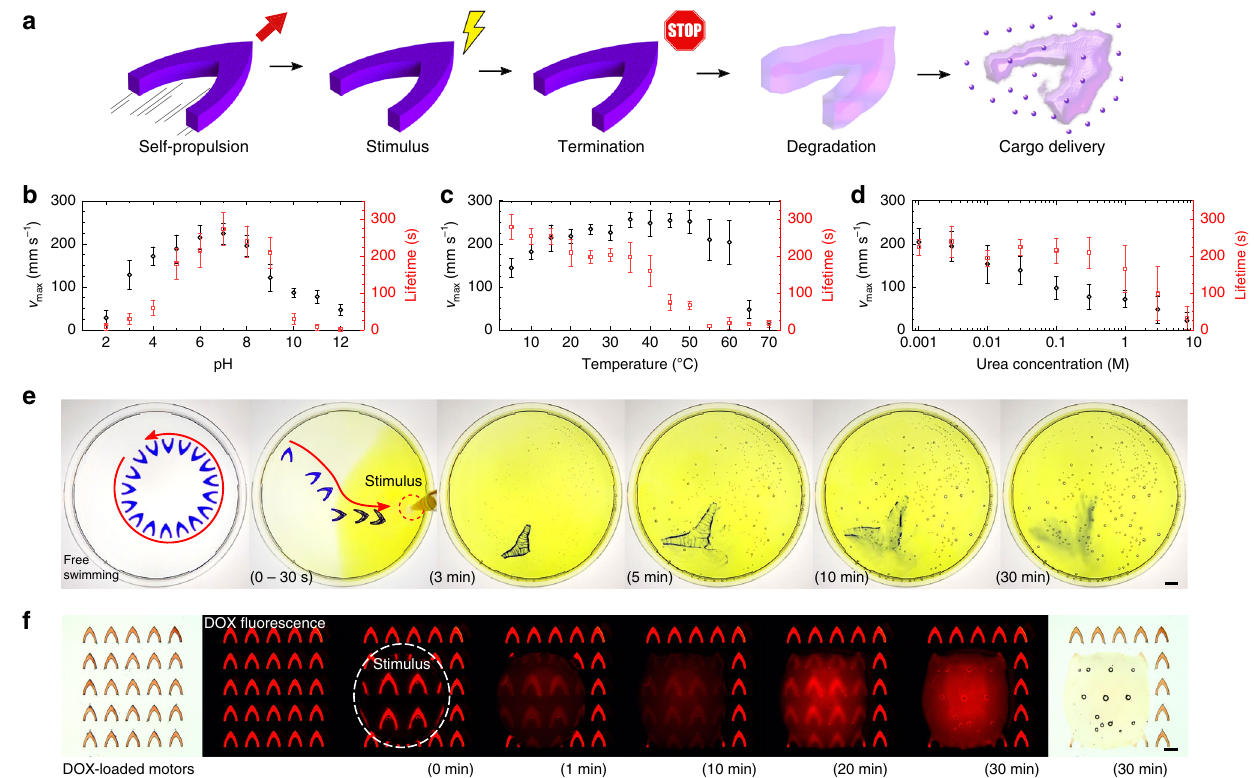
Fig. 5 a Protein motor on-demand termination and degradation for cargo delivery. b pH, c urea, and d temperature stimuli reduce the mobility lifetime and ultimately terminate the locomotion. Black circles are v max , red squares are continuous mobility lifetime. Error bars represent standard deviation, n = 15. e Degradation and cargo release. Free-swimming l = 10 mm motor reacts to a pH stimulus by moving towards low pH and reducing its lifetime. Once stopped, the motor swells and degrades over 30 min, releasing its encapsulated cargo (scale bar: 10 mm). f Stimuli-responsive release of DOX from l